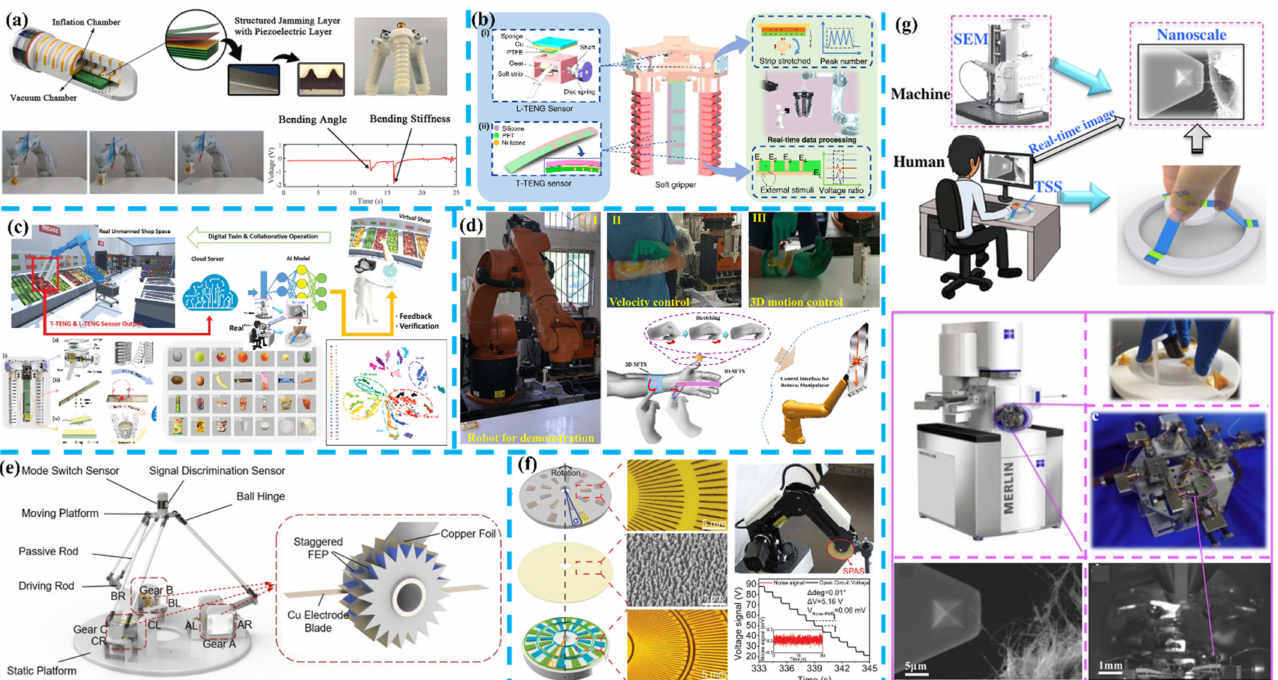
Figure 7. Robotics. ( a ) Flexible self-powered multifunctional sensor for stiff-ness-tunable soft robotic gripper (Reprinted with permission from ref. [255]. Copyright 2021 Elsevier). ( b ) Triboelectric nanogenerator sensors for soft robotics aiming at digital twin applications (Reprinted with permission from ref. [6]. Copyright 2021 Nature). ( c ) Artificial Intelligence of Things (AIoT) enabled virtual shop applications using self-powered sensor enhanced soft robotic manipulator (Reprinted with permission from ref. [259]. Copyright 2021 John Wiley & Sons). ( d ) Triboelectric self-powered wearable flexible patch as 3D motion control interface for robotic manipulator (Reprinted with permission from ref. [260]. Copyright 2018 American Chemical Society). ( e ) A Delta-parallel-inspired human-machine interface by using self-powered triboelectric nanogenerators toward 3D and VR/AR manipulations (Reprinted with permission from ref. [261]. Copyright 2020 American Chemical Society). ( f ) A self-powered angle sensor at nano-radian-resolution for robotic arms (Reprinted with permission from ref. [262]. Copyright 2020 John Wiley & Sons). ( g ) Intuitive-augmented multidimensional nano-manipulation terminal using triboelectric stretchable strip sensors (Reprinted with permission from ref. [263]. Copyright 2019